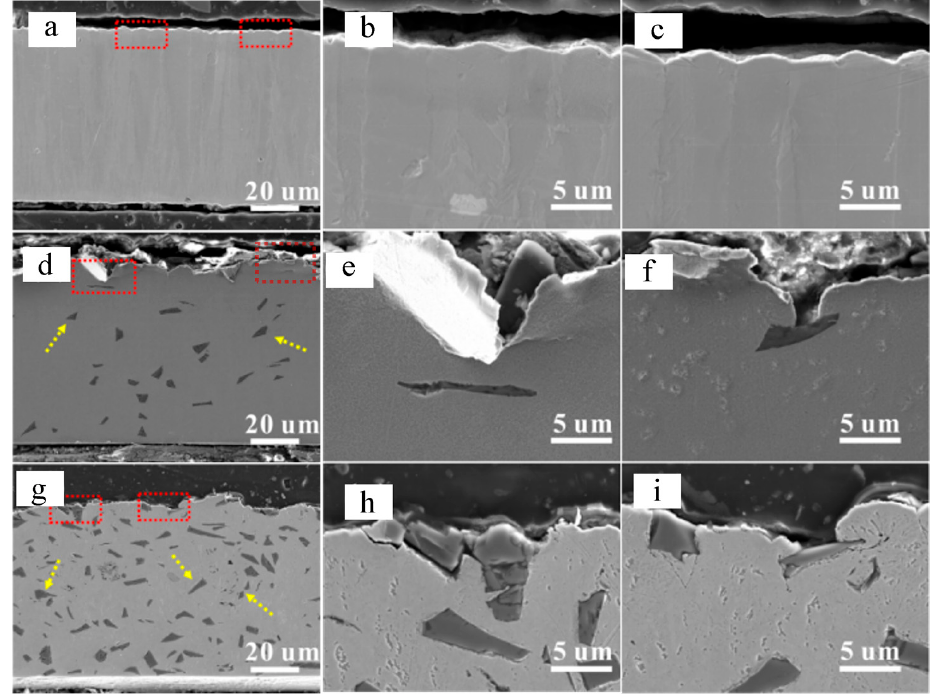
Figure 3. SEM cross-section view of ( a ) pure Ni coating and Ni-SiC composite coatings electrode- posited in Watts bath containing ( d ) 40 and ( g ) 250 g/L SiC microparticles; ( b , c , e , f , h , i ) enlarge pictures of the red dot line marked positions in ( a , d , g ). Figure 3f is out of the visual field in Figure 3d.